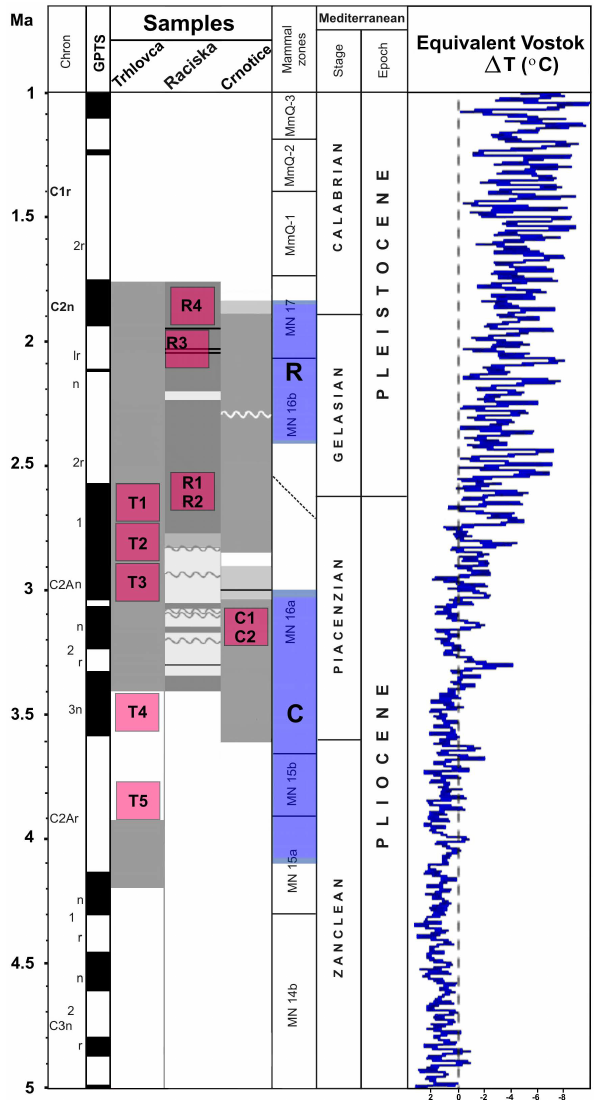
Fig. 4. A correlation of the obtained magnetostratigraphic results with the standard paleomagnetic scale (GPTS; after Cande and Kent, 1995; modified after Hor´aˇcek et al., 2007), mammal zones, temperature estimates (after Lisiecki and Raymo, 2005) and posi- tion of the samples with invertebrates (in red) and vertebrates (in blue): T=Trhlovca Cave, R=Raˇciˇska Cave, C=fossil cave in the ˇCrnotiˇce